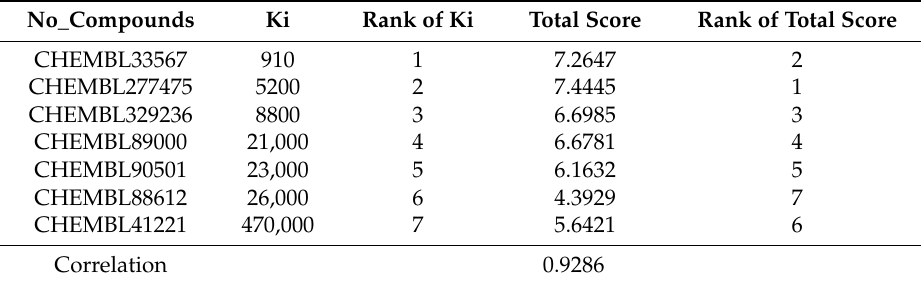
Table 5. The data of correlation between the rank of compounds experimental affinity (Ki) and docking score of mGluR4.